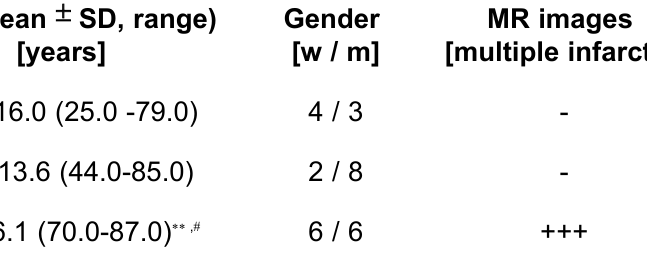
Table 1. Patients characteristics: w = woman, m = male, MR = magnetic resonance, IPD = idiopathic Parkinson's disease, VP = vascular parkinsonism (mean values ± S.D. are given); ∗∗ p < 0.001 compared to controls, # p < 0.012 compared to